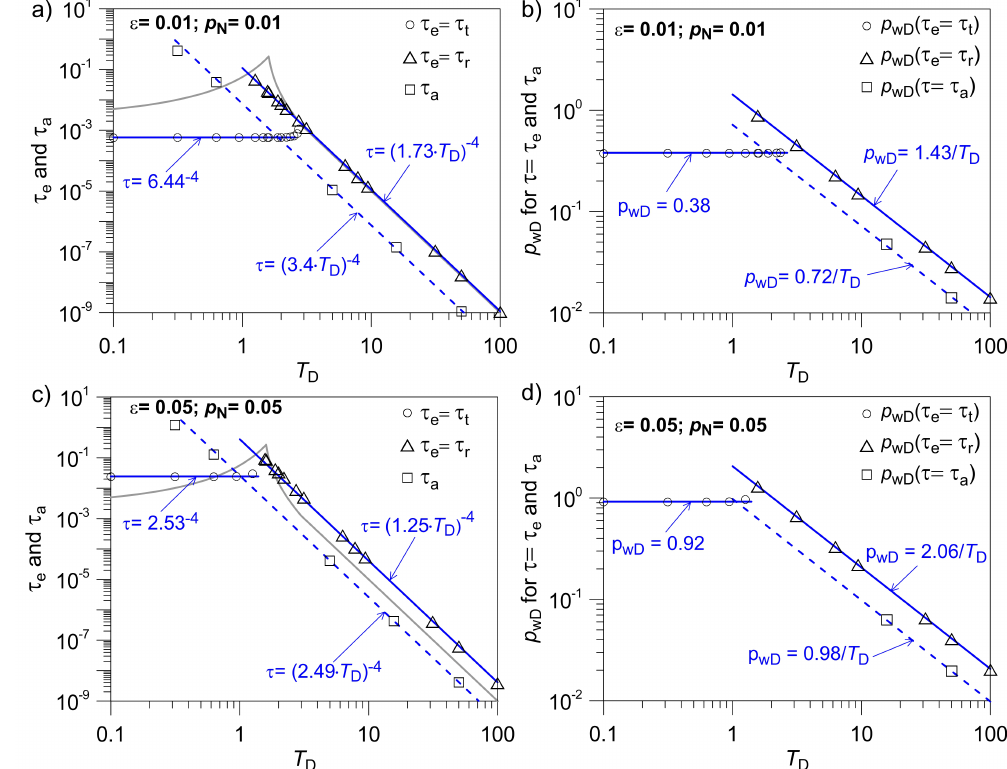
Fig. 8. Dimensionless end times τ e according to the transition mechanism ( τ t ) and reflection mechanism ( τ r ) , Eqs. (18) and (19), respectively, and dimensionless arrival time τ a of the indicated isobar at the fracture tip for (a) ε = p N = 0 . 01 and (c) ε = p N = 0 . 05. The dimensionless end time reported by Cinco-Ley and Samaniego (1981) is represented by thin grey lines. Fit equations for the calculated end and arrival times are represented with blue lines and blue dashed lines, respectively. Note that τ r and τ a differ by a factor of 16. Dimensionless well pressure at τ e and τ a . Note that the dimensionless well pressures for τ r and τ a differ by a factor of 2. Fit equations for the calculated dimensionless well pressure are represented with blue lines and blue dashed lines by τ = τ e and τ = τ a ,